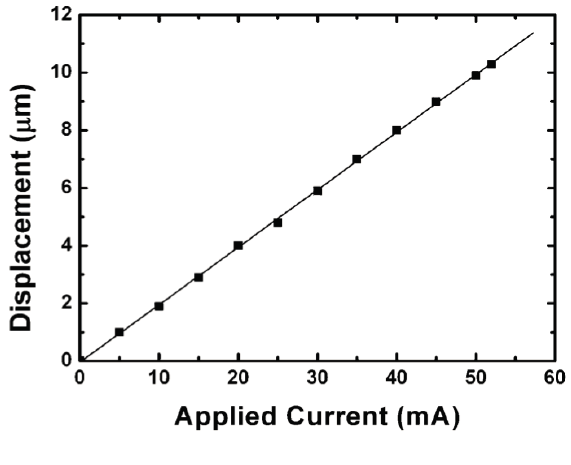
Figure 13. Displacement as function of actuation current in the device proposed by Cho et al . [83]. Reprinted with permission from [83]. Copyright 2005